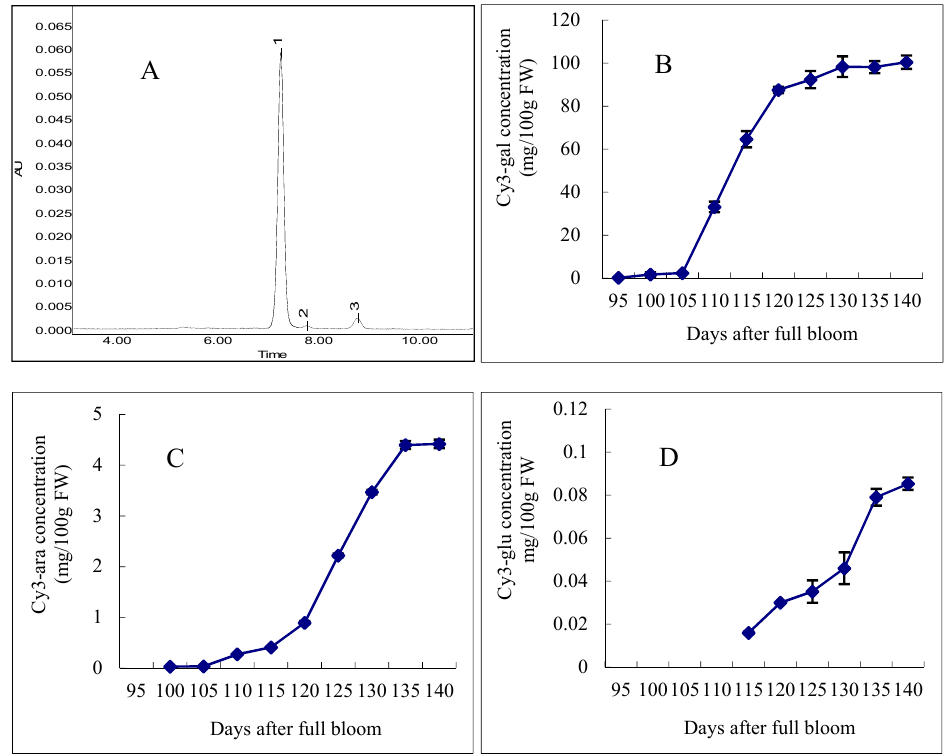
Figure 2. HPLC separation and concentration changes of anthocyanins in “Starkrimson” apple peel during ripening period. ( A ) “Starkrimson” apple peel monitored at 530 nm. Peaks: 1 cyanidin 3-galactoside; 2 cyanidin 3-glucoside; 3 cyanidin 3-arabinoside; ( B – D ) concentration and changes of cy3-gal, cy3-ara and cy3-glu in “Starkrimson” apple peel during ripening period and values are means ± SE ( n = 4).